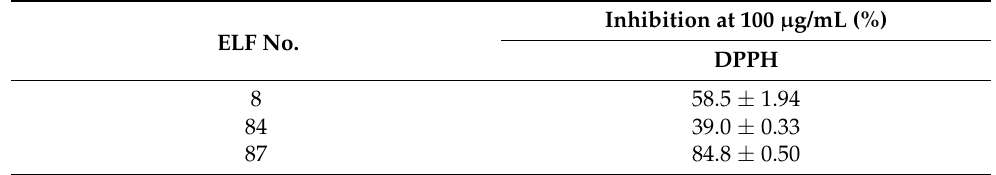
Table 2. DPPH (2,2-diphenyl-1-picrylhydrazyl) antioxidant activity of endogenous lichen